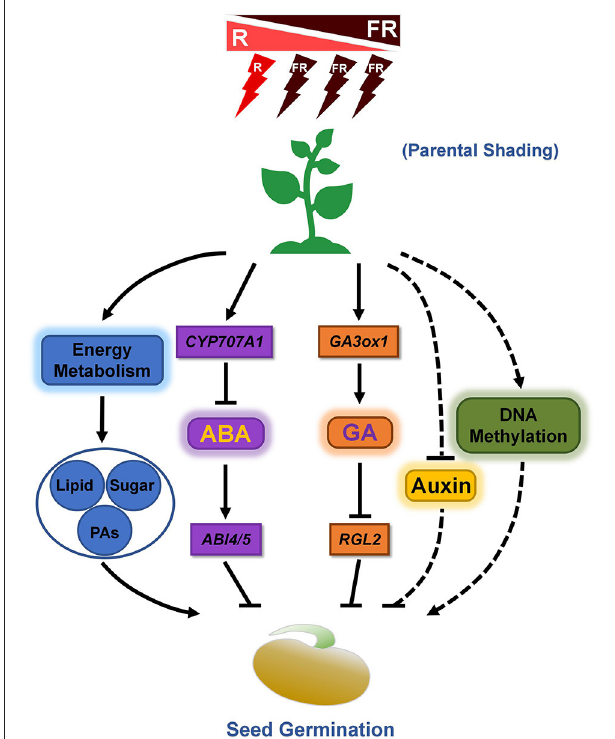
FIGURE 1 | Proposed effects of shading of the mother plant on subsequent seed germination. Parental shading environment regulates seed germination by mediating the biosynthesis and signaling cascade of key phytohormones (ABA and GA), TAG content, and concentration of several types of fatty acid, sugars, and pro-anthocyanidins (PAs) in soybean (Chen et al., 2020). Furthermore, parental shading may also influence the DNA methylation level of some key genes which are involved in seed germination control in Polygonum persicaria (Baker et al., 2018), while the detailed mechanisms need to be further explored. In addition, given the promotion roles of auxin on seed dormancy ( Liu et al., 2013), it is strongly suggested that auxin biosynthesis and signaling play some uncovered role in parental shading-mediated subsequent seed